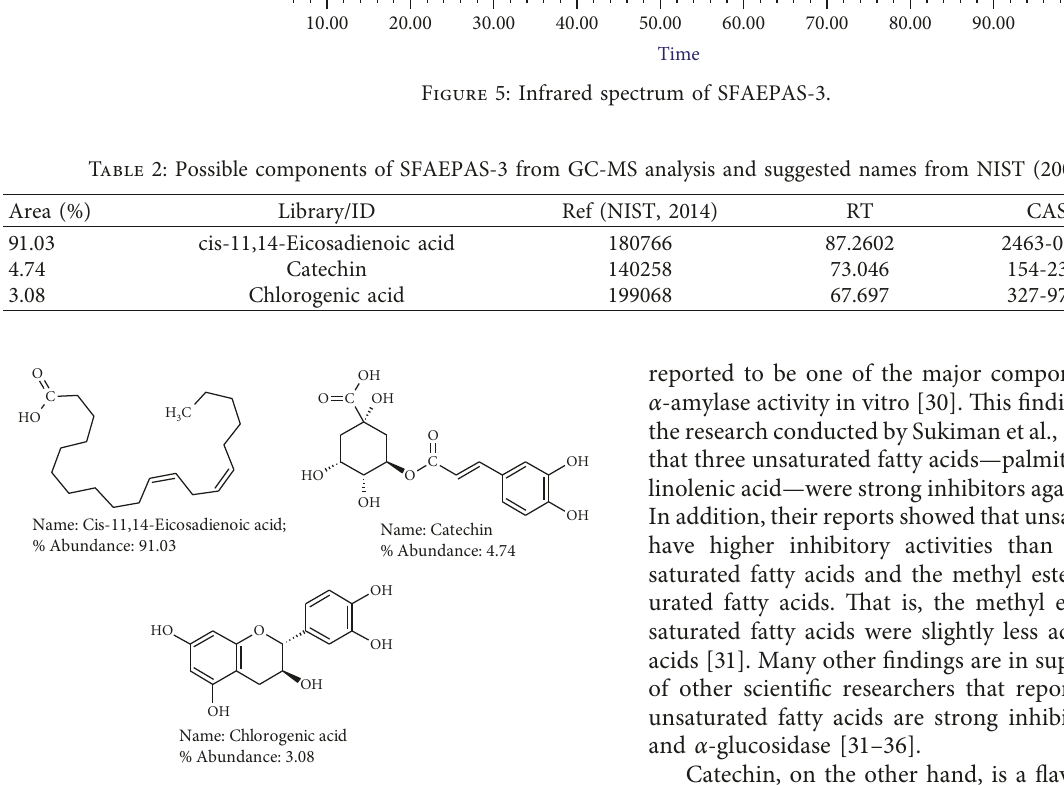
Figure 6: Suspected compounds found in SFAEPAS-3 through